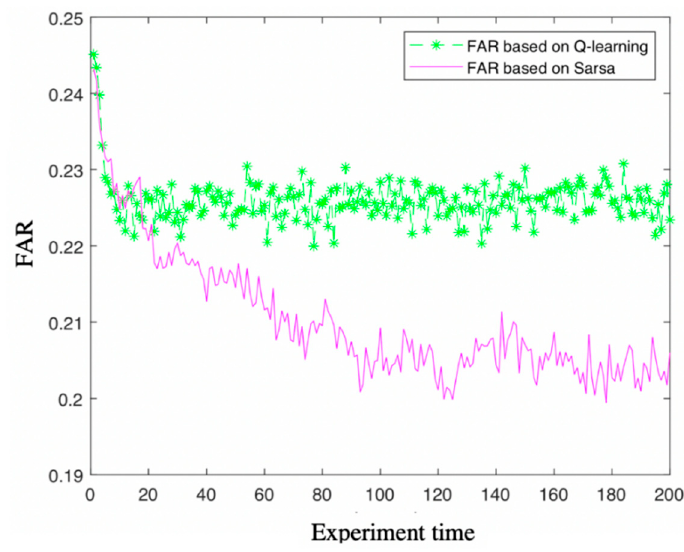
Figure 6. The comparison of FAR based on SARSA and Q-learning.